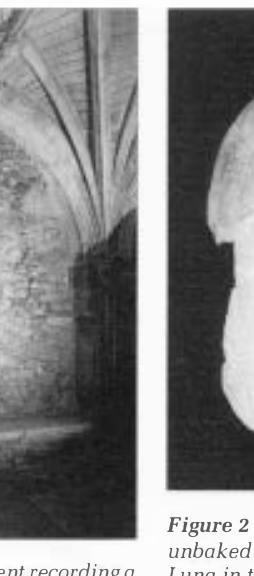
Figure 1 An Institute student recording a medieval doorway in the church of St Bar­ tholomew the Great, London.